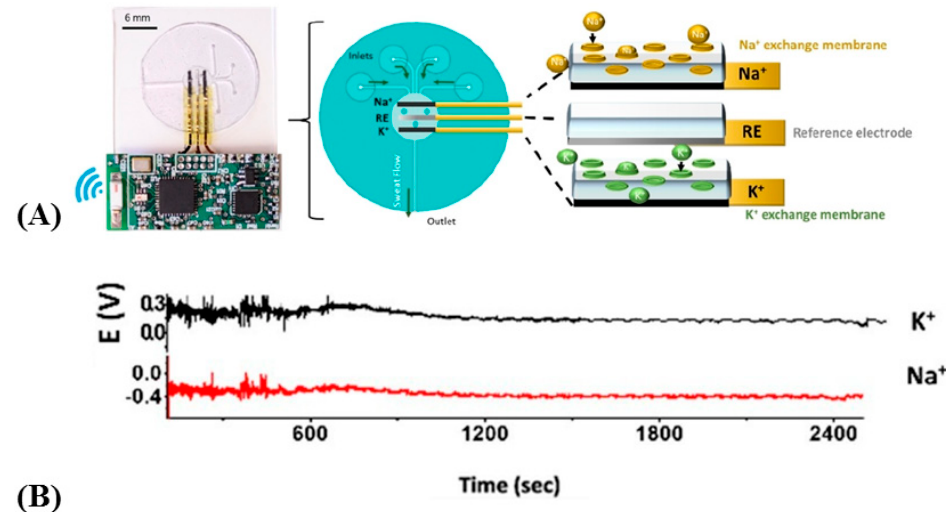
Figure 16. ( A ) Picture of the whole device (left) and schematic view of microfluidic chambers and channels into which are integrated the ion selective electrodes (right). ( B ) Simultaneous recording of the ISE potentials for Na + and K + for a sensor mounted on the shoulder of a bicycle pedaling subject. Reproduced from [58] with permission. © 2019 Wiley-VCH Verlag GmbH & Co. KGaA, Weinheim.